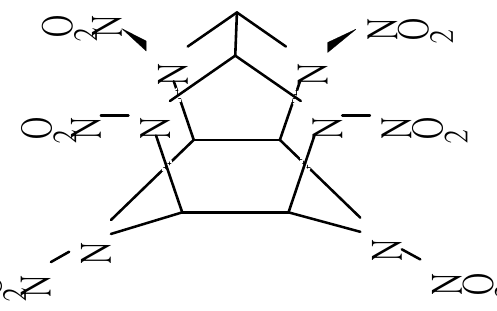
Figure 8. Schematic diagram of molecular structure for CL-20.